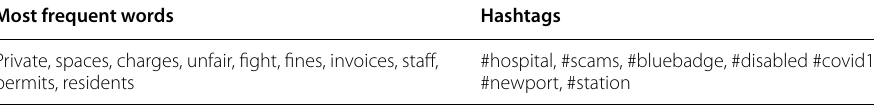
Table 8 Hashtags, and most frequent words within the marketing community Most frequent words Private, spaces, charges, unfair, fight, fines, invoices, staff, permits,